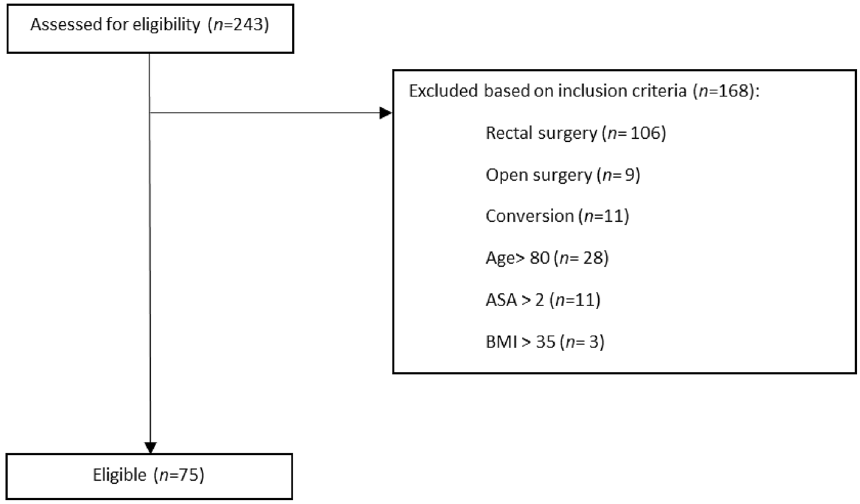
Figure 2. Consort diagram. Flowchart retrospective cohort.